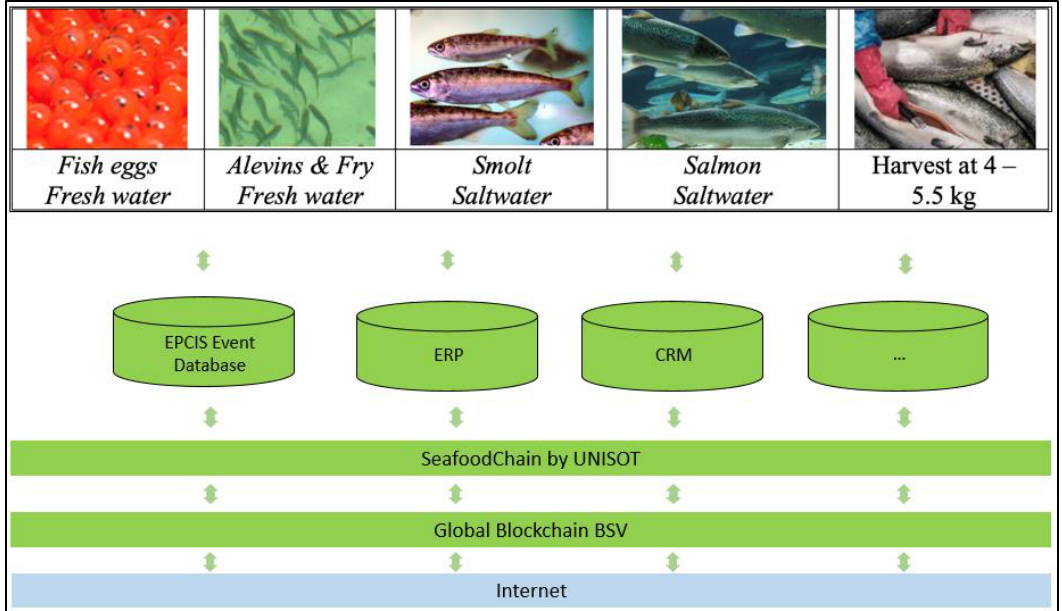
Figure 6. Internal fish farm enterprise-level IoT Platform with EPCIS server, ERP and CRM system, the SeafoodChain blockchain interface, and its connection to the global blockchain data layer.